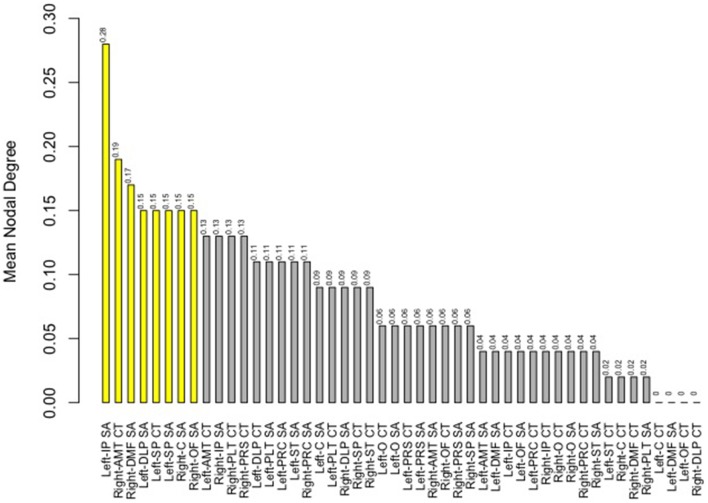
Above is a barplot of the average nodal degree of each of the parcellations, from greatest to least. Table 1 presents the parcellation abbreviations for reference. Yellow bars indicate parcellations >1.0 standard deviation from the mean.